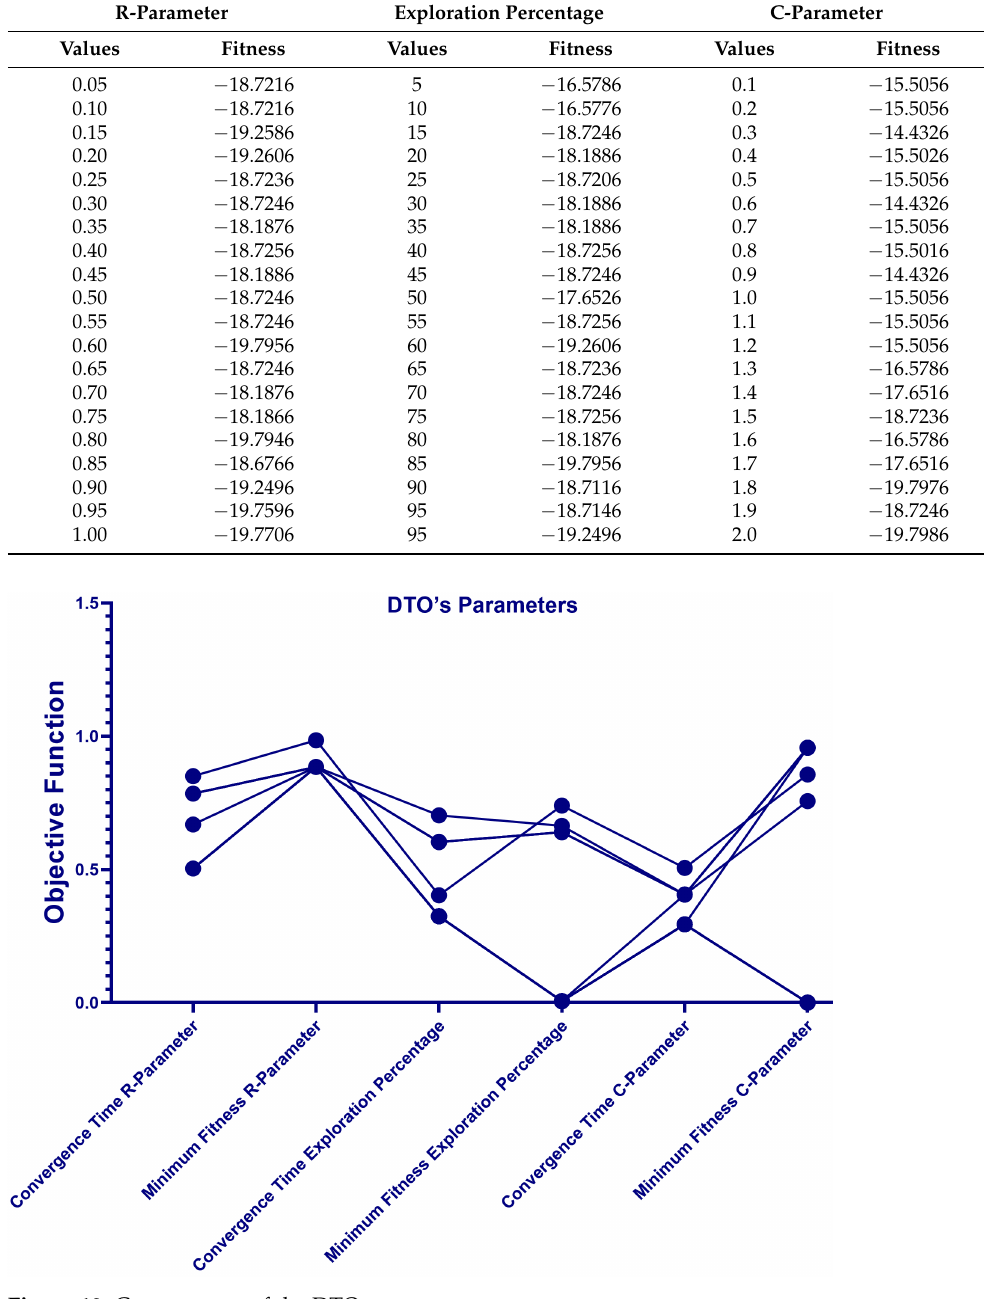
Figure 10. Convergence of the DTO